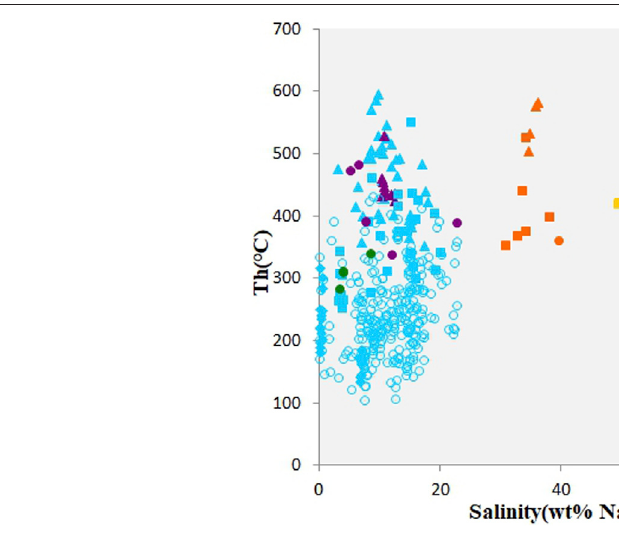
Frontiers in Earth Science |